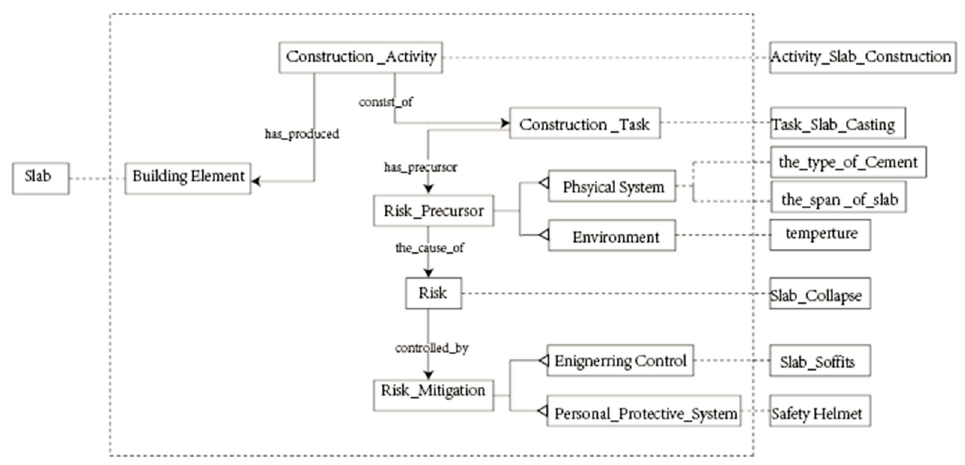
Figure 11. Slab Casting task-related classes and attributes used in SWRL rules 1, 2 and 3. Eurocode 2: DCS Regulation: